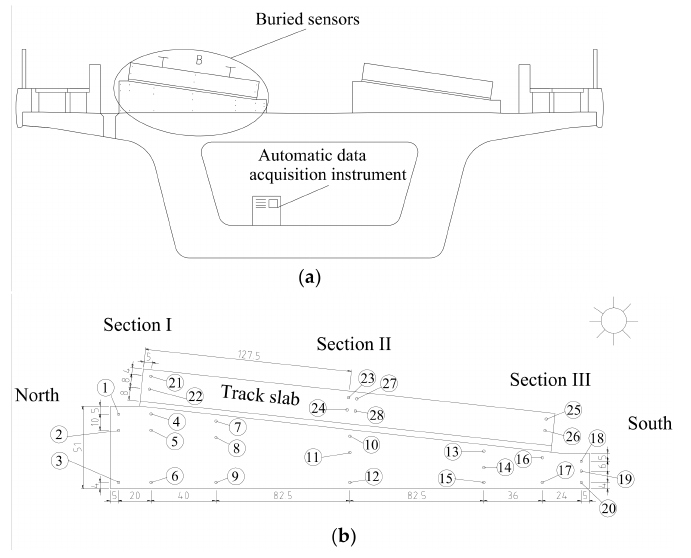
Figure 2. Schematic diagram of temperature sensor arrangement: ( a ) structural drawing of beam cross-section; ( b ) schematic diagram of 28 temperature sensors embedding in ballastless